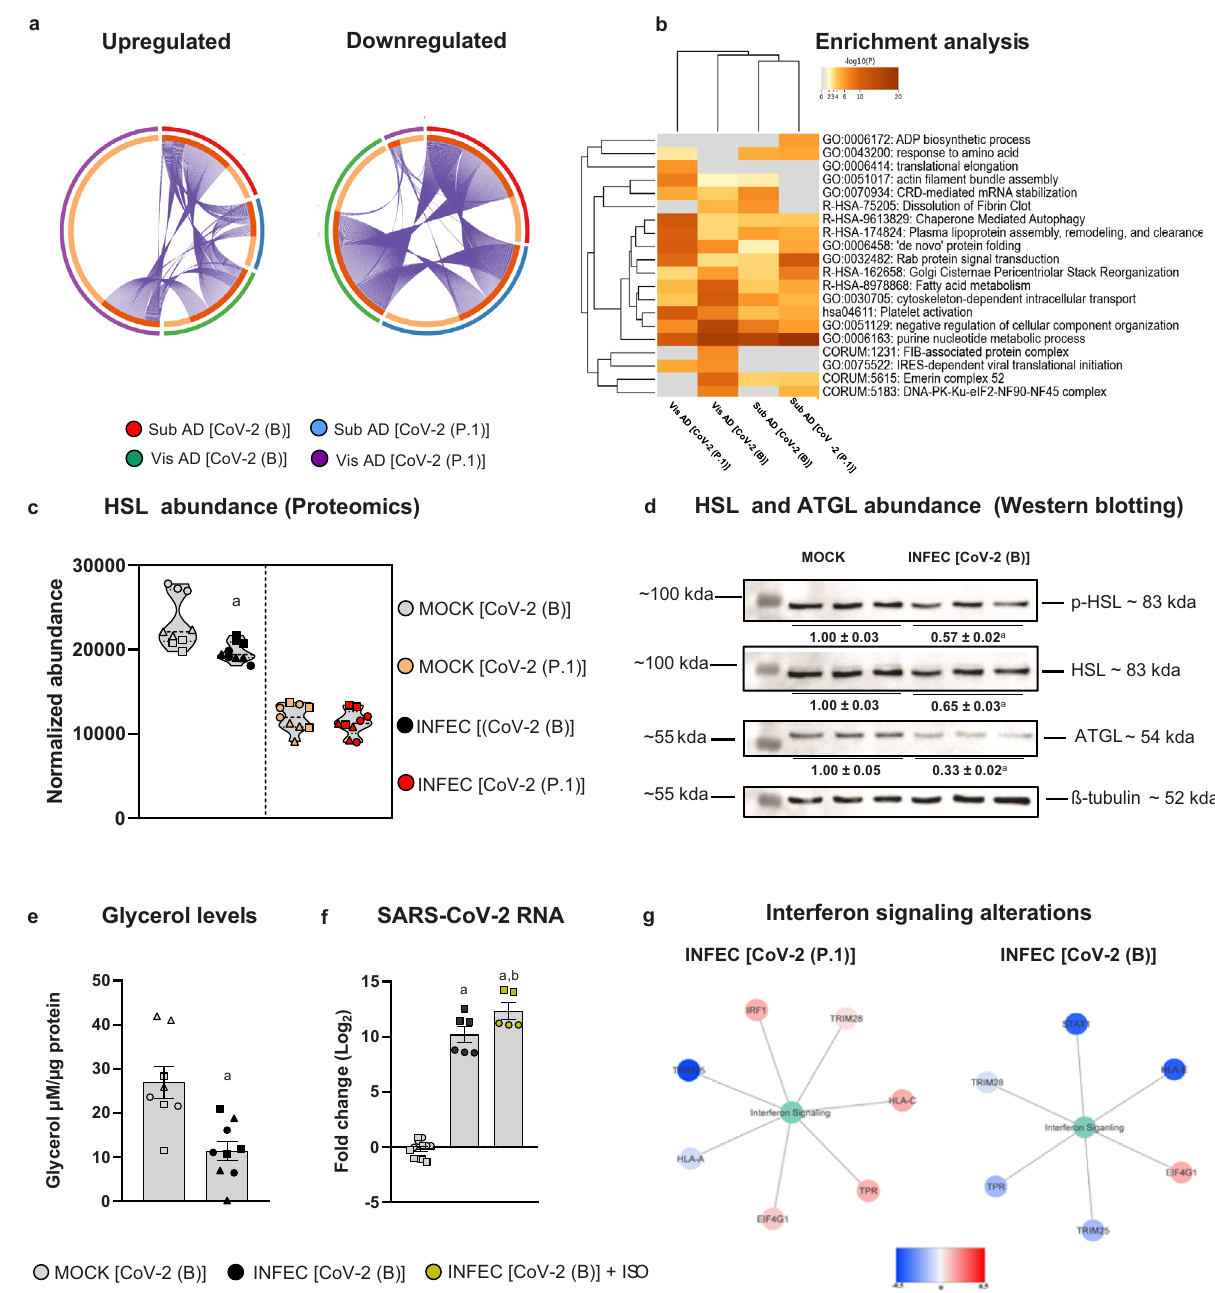
Fig. 4 | SARS-CoV-2 infection of fat cells results in different cellular responses depending on the depot of origin and the viral lineage. Stromal-vascular cells from human subcutaneous and visceral fat depots were differentiated into adipo- cytes (Sub AD and Vis AD, respectively) and infected (INFEC) or not (MOCK) with the SARS-CoV-2 ancient strain [CoV-2(B)] or the P.1 variant [CoV-2(P.1)]. a Overlap between differentially expressed proteins as determined by proteomics. Arcs represent different infection conditions (outside) or differentially expressed pro- teins (inside). Dark and light orange represent proteins that are differentially expressed in multiple conditions (linked by purple lines) or in only one condition, respectively. b Enriched ontology clusters. Statistically enriched terms were hier- archically clustered and the top-ranked terms within each cluster were displayed. c HSLabundance.Signi fi cantdifferencesweredeterminedbyANOVAanddepicted as: a, P <0.01 vs. MOCK CoV-2(B). d Western blotting of phosphorylated HSL (p- HSL), total HSL, ATGL, and α -tubulin as the loading control. Quanti fi cation repre- sents the mean±SEM of three independent pools from one donor. Signi fi cant differences were determined by a two-tailed Student ’ s t -test: a, P <0.01. e Glycerol